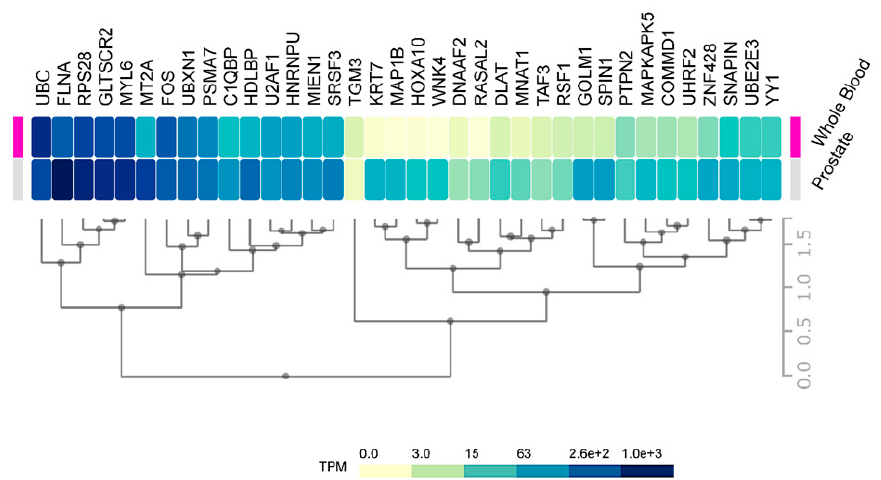
Figure 7. Prostate and blood levels of HMGB1 and HMGB2 interactome targets in healthy men: Expression of HMGB1 and HMGB2 interactome targets in prostate tissue and whole blood in healthy men. Data were directly obtained and processed from the GTEx Project through Expression Atlas, an integrated database of gene and protein expression in humans, animals, and plants [105], accessed through https://www.ebi.ac.uk/gxa/ experiments/E-MTAB-5214/Results.